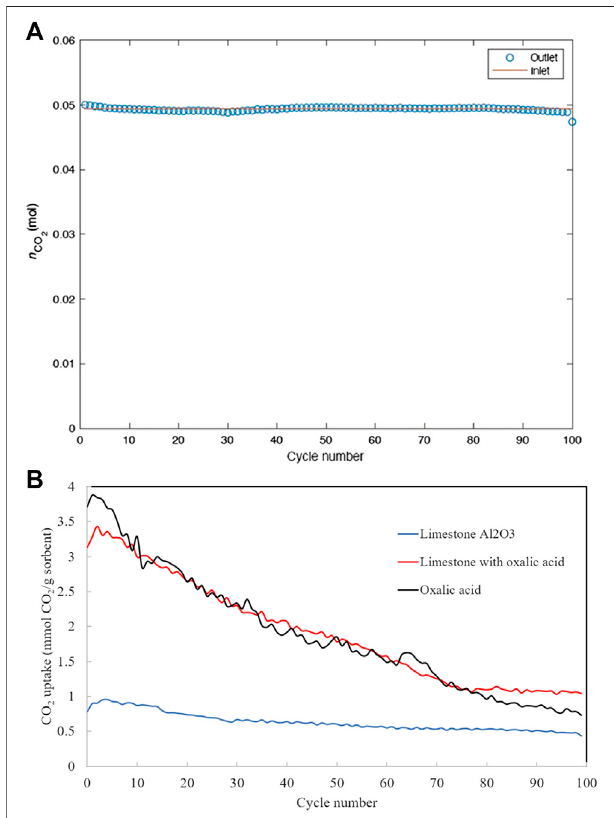
FIGURE5|(A) Carbonbalanceover100carbonation-calcinationcycles and (B) CyclicCO 2 uptakecapacityofthe fi vesorbentsover100carbonation- calcination